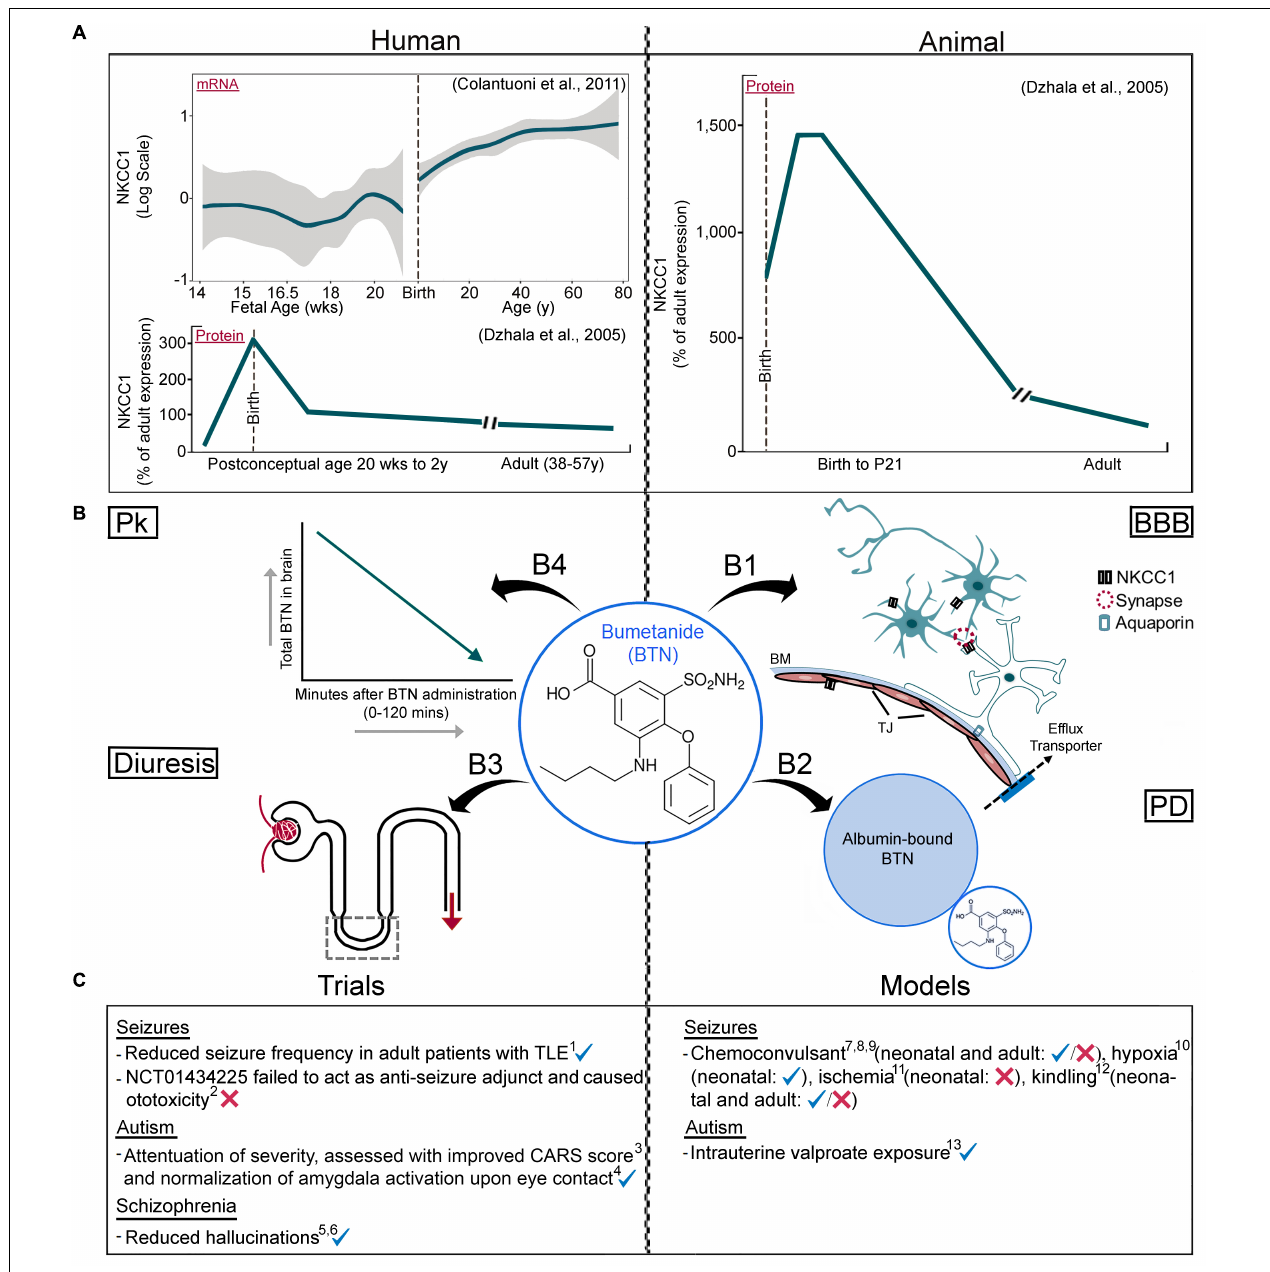
FIGURE 1 | Parsing information about NKCC1 isoforms and BTN (A) Human vs. rodent NKCC1 expression profiles. mRNA data from microarray probe (hH034657, Illumina Technologies - probe chosen specifically because it spans most of NKCC1) shows developmental upregulation, followed by NKCC1a protein data using western blotting techniques showing a developmental downregulation. Rodent data of NKCC1a protein shows a developmental downregulation, quantitated with western blotting techniques and consistent with human data analyzed with western blotting using the same probes. (B) Pharmacological attributes of BTN affecting its direct neuronal modulation; (B1) BBB, neuronal and non-neuronal NKCC1, (B2) Albumin’s high affinity to BTN, (B3) BTN’s diuretic effects, (B4) BTN’s short half-life in serum and brain. (C) Clinical trials and pre-clinical models with varying results of BTN efficacy, see Table 1 for further details. Pk, pharmacokinetics; BBB, Blood–Brain Barrier; PD, pharmacodynamics; BM, basement membrane; TJ, tight junction. Panel A data adapted from Dzhala et al., 2005 with permission and Colantuoni et al., 2011 (graphed brain cloud data replotted with R statistical